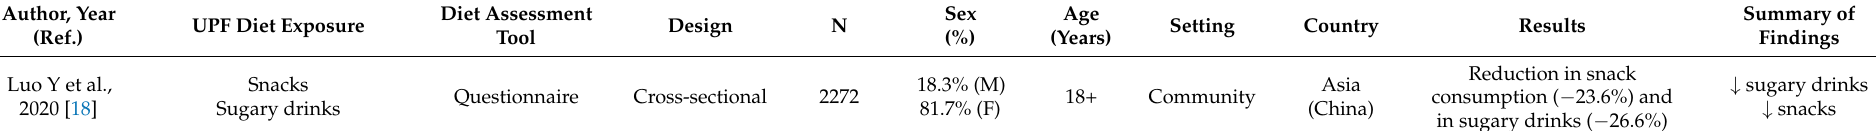
Table 2. Selected studies investigating changes in ultra-processed food consumption during the period of SARS-CoV-2 lockdown compared with previous habits (N =